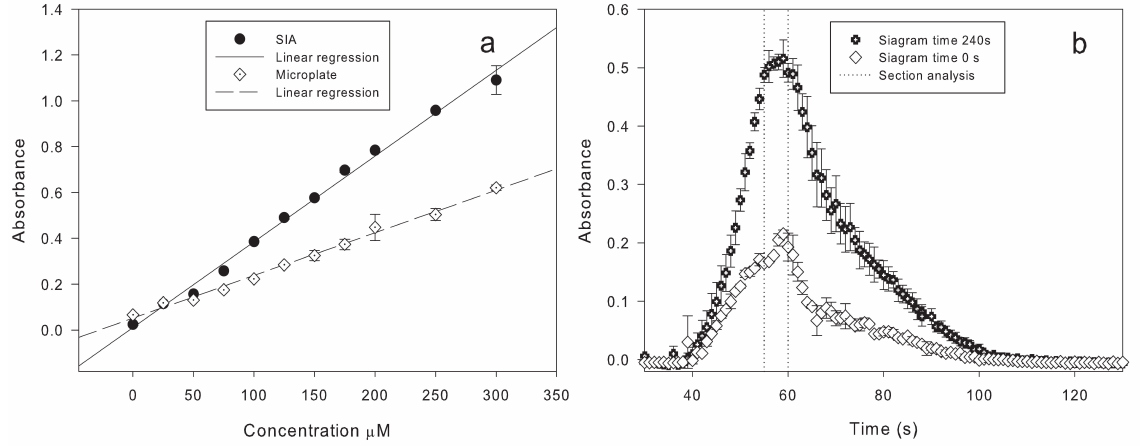
Figure 5. Determination of the molar extinction coefficient and “stopped flow” for the lipase/esterase activity using p -NPB as the substrate: ( a ) calibration curve of p -nitrophenol microplate Xmark vs . the SIA system; ( b ) “stopped flow” determination in two elapsed times of reaction, 0 s and 240